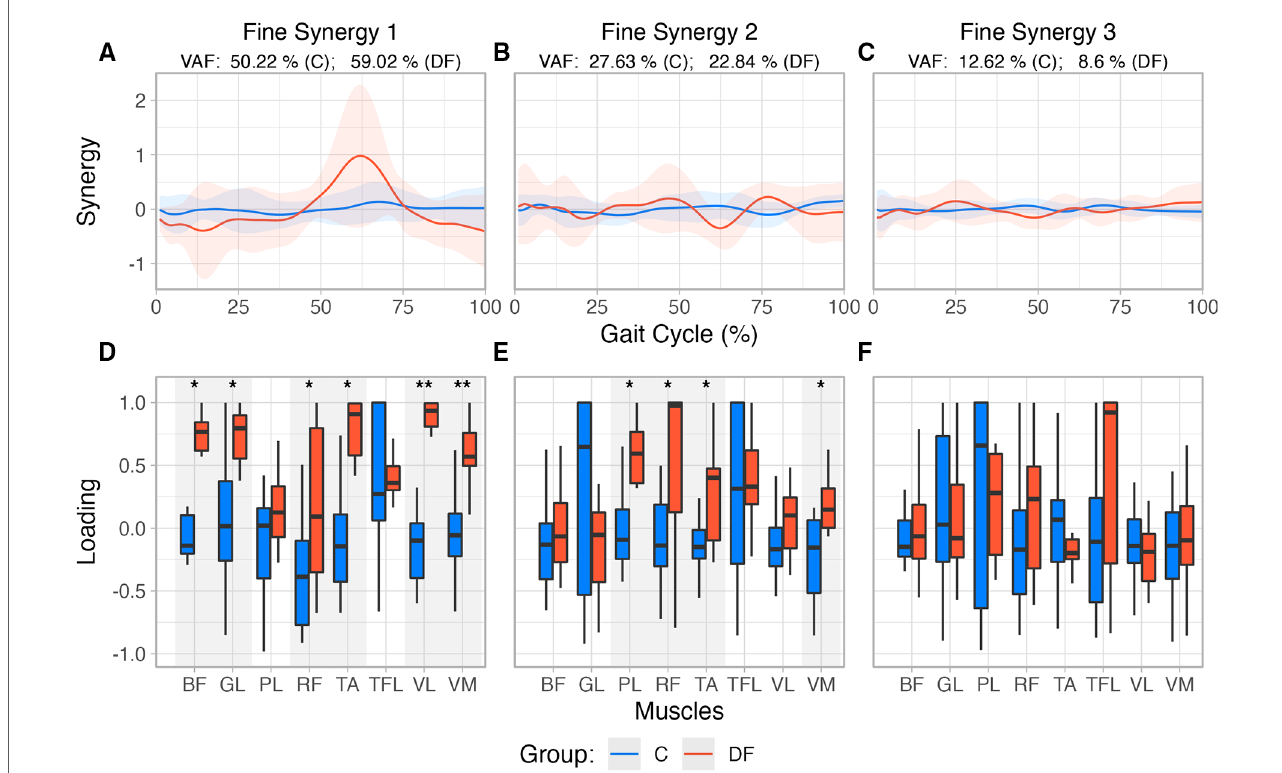
FIGURE 4 ( A – C ) Reconstructed muscle activity pro fi les based on loadings extracted from fi rst three “ fi ne synergies ” for each group. ( D – F ) Fine synergies loadings extracted from PCA for unimpaired control participants and persons with drop foot. Also note the loadings in DF are in general closer to þ 1 in the DF case, indicating greater synergistic correlation among muscle